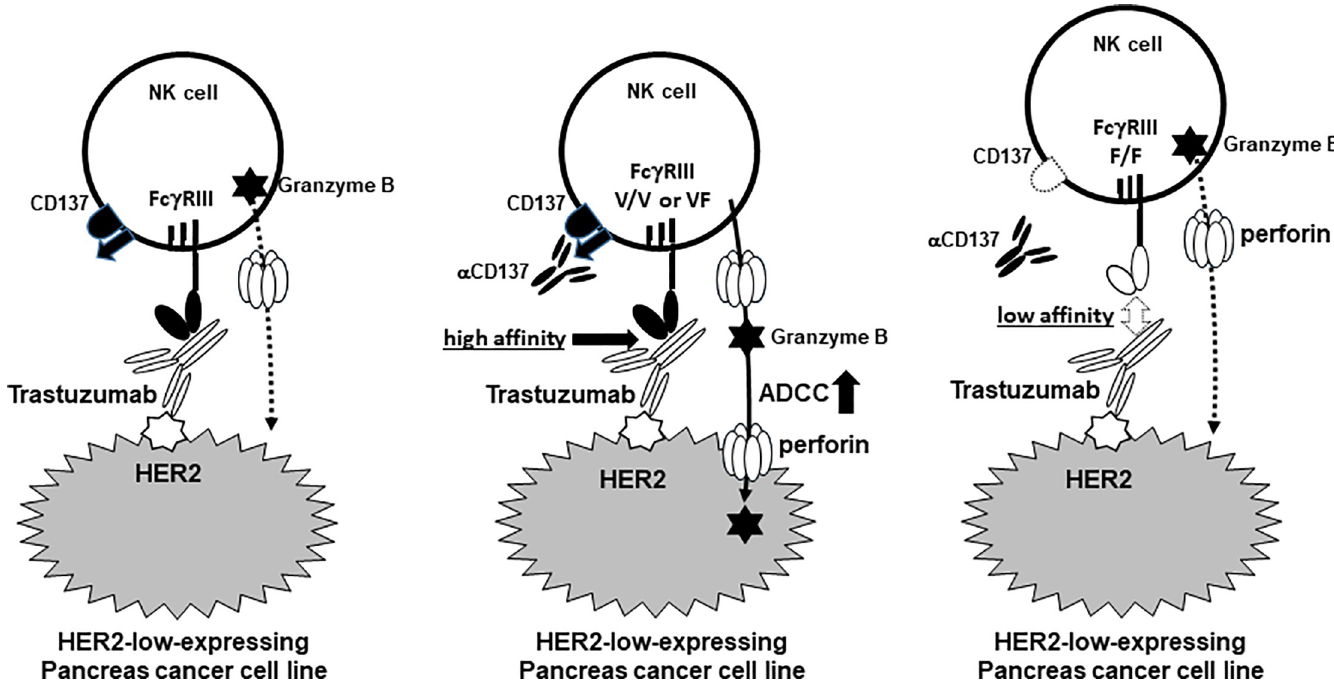
Fig 8. Schema illustrated the contribution of aCD137 and Fc γ R-III polymorphism for trastuzumab-mediated ADCC against HER2-low-expressing human pancreas cancer cell line.